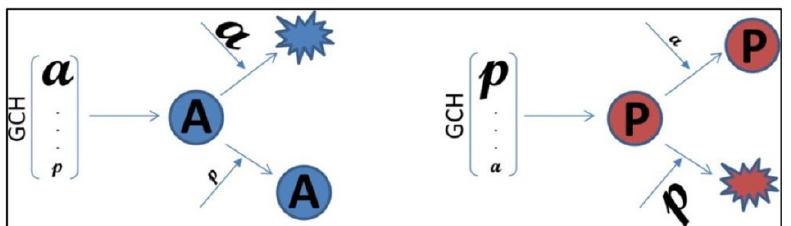
Figure 1. Experimental design to validate the Gene Master Regulators (GMR) theory. a is a gene with higher Gene Commanding Height ( GCH ) in the A -cells (here the 8505C anaplastic thyroid cancer cell line) than in the P -cells (here the BCPAP papillary thyroid cancer cell line), while p is a gene with higher GCH in the P -cells than in the A -cells. The theory is verified if transfection of a will induce significantly larger Weighted Pathway Regulation ( WPR ) in the A -cells than in the P -cells and transfection of p will induce larger WPR in the P -calls than in the A -cells